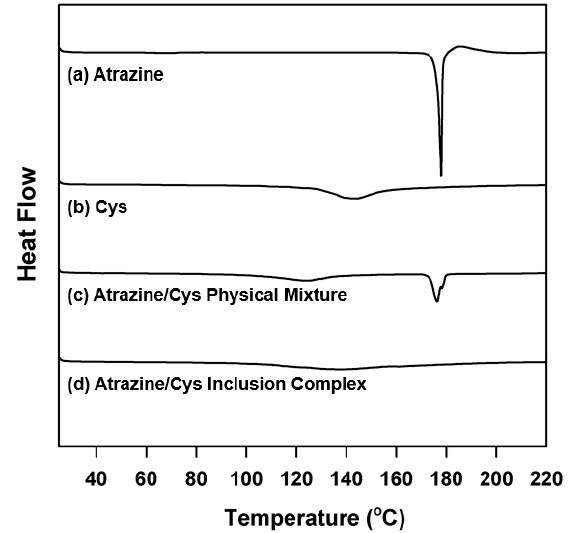
Figure 5. DSC curves of ( a ) atrazine; ( b ) Cys; ( c ) atrazine/Cys physical mixture; ( d ) atrazine/Cys inclusion complex.